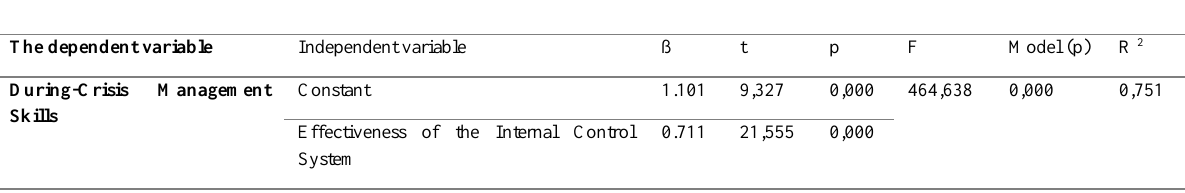
Table 6: The Effect of Internal Control System on Management Skills in Crisis Period